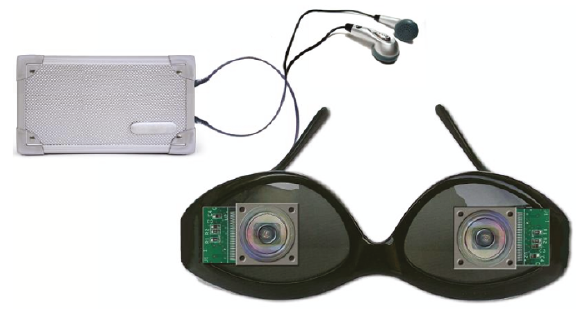
Figure 11: Anticipated embedded stereo vision